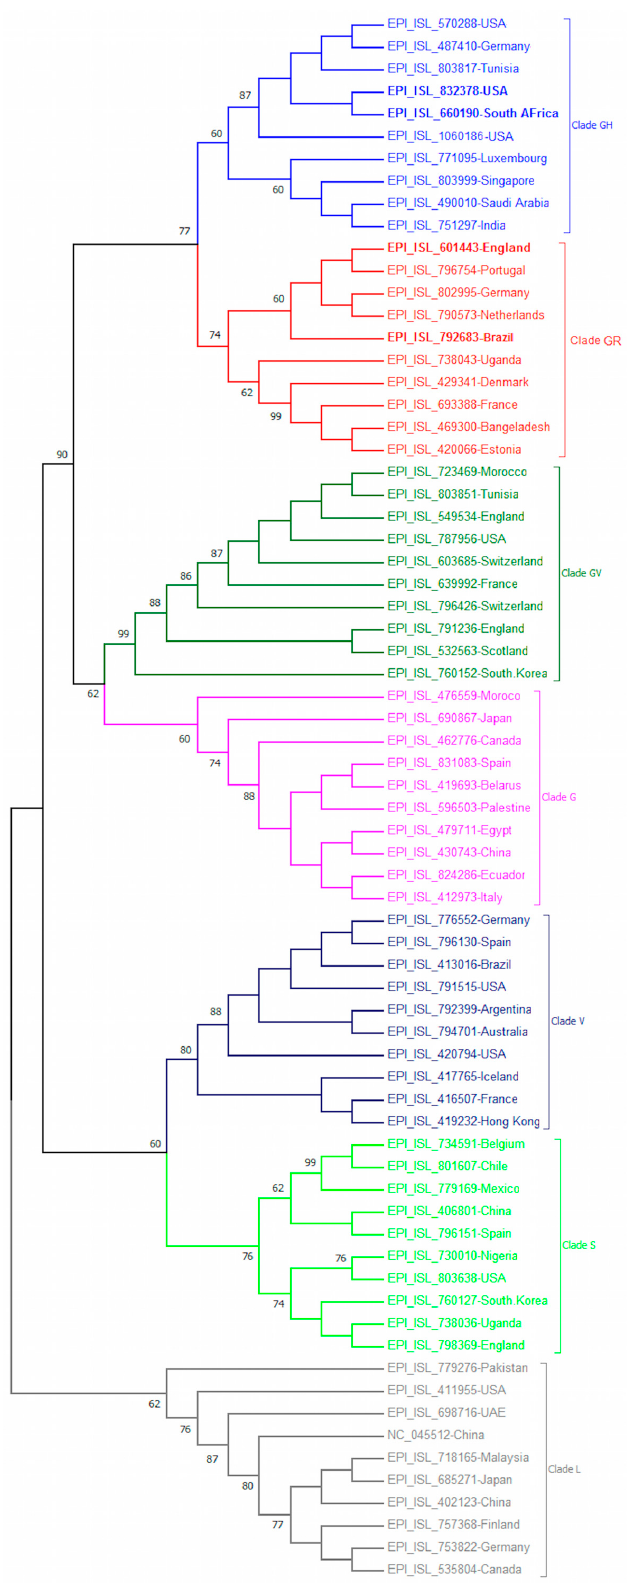
Figure 1. The phylogenetic tree was constructed using Geneious software. The percentage of trees in which the associated taxa clustered together is shown next to the